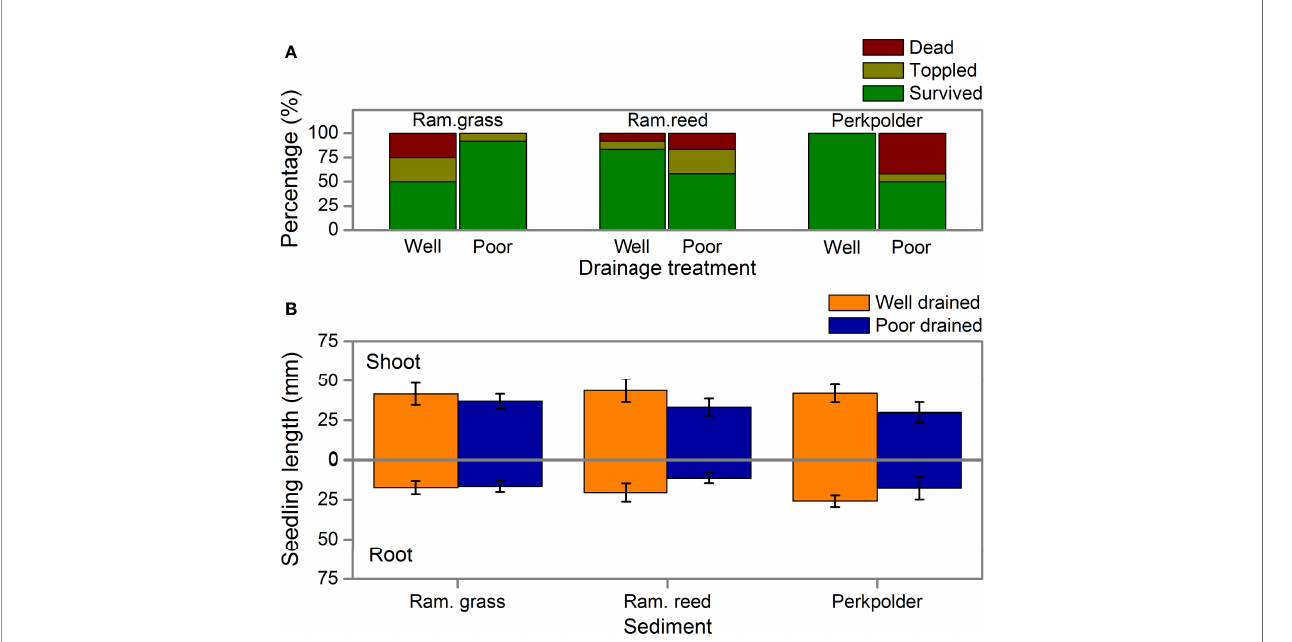
FIGURE 2 | (A) Percentage of survived (dark green), toppled (dark yellow), and dead seedlings (dark red) at harvest in the mesocosm experiment, well drained and poor drained treatments are indicated at the bottom of the panel; (B) seedling length under 6 treatments after 20 days cultivating in the mesocosms. In (B) , the well- drained and poor drained treatments were presented in orange and blue respectively. The three kinds of sediments (Ram.grass, Ram.reed, and Perkpolder) were shown for each column. (Data is presented as mean + se.).